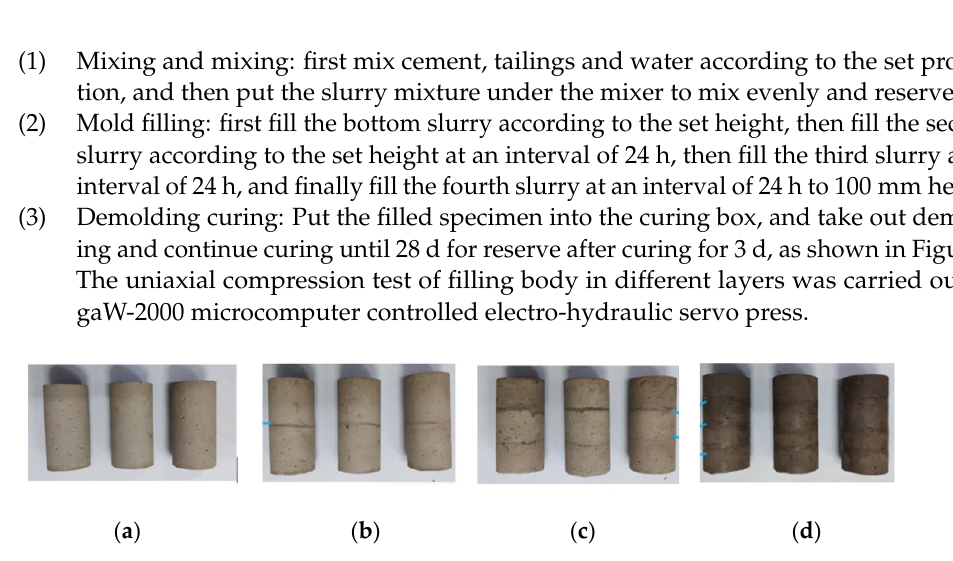
Table 1. Single layer flow test scheme and results. Figure 6. Delamination filling body test block: ( a ) One layer; ( b ) Two layers; ( c ) Three layers; ( d ) Four layers.